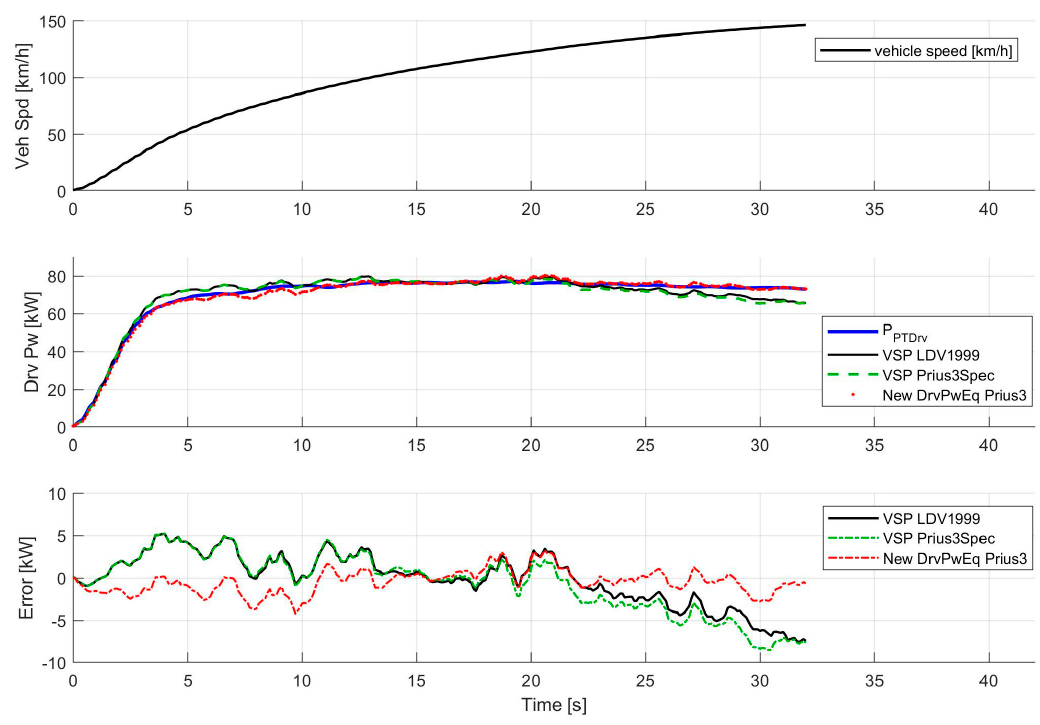
Figure 7. Prius3 driving-power prediction results during heavy-load driving during maximal acceleration.